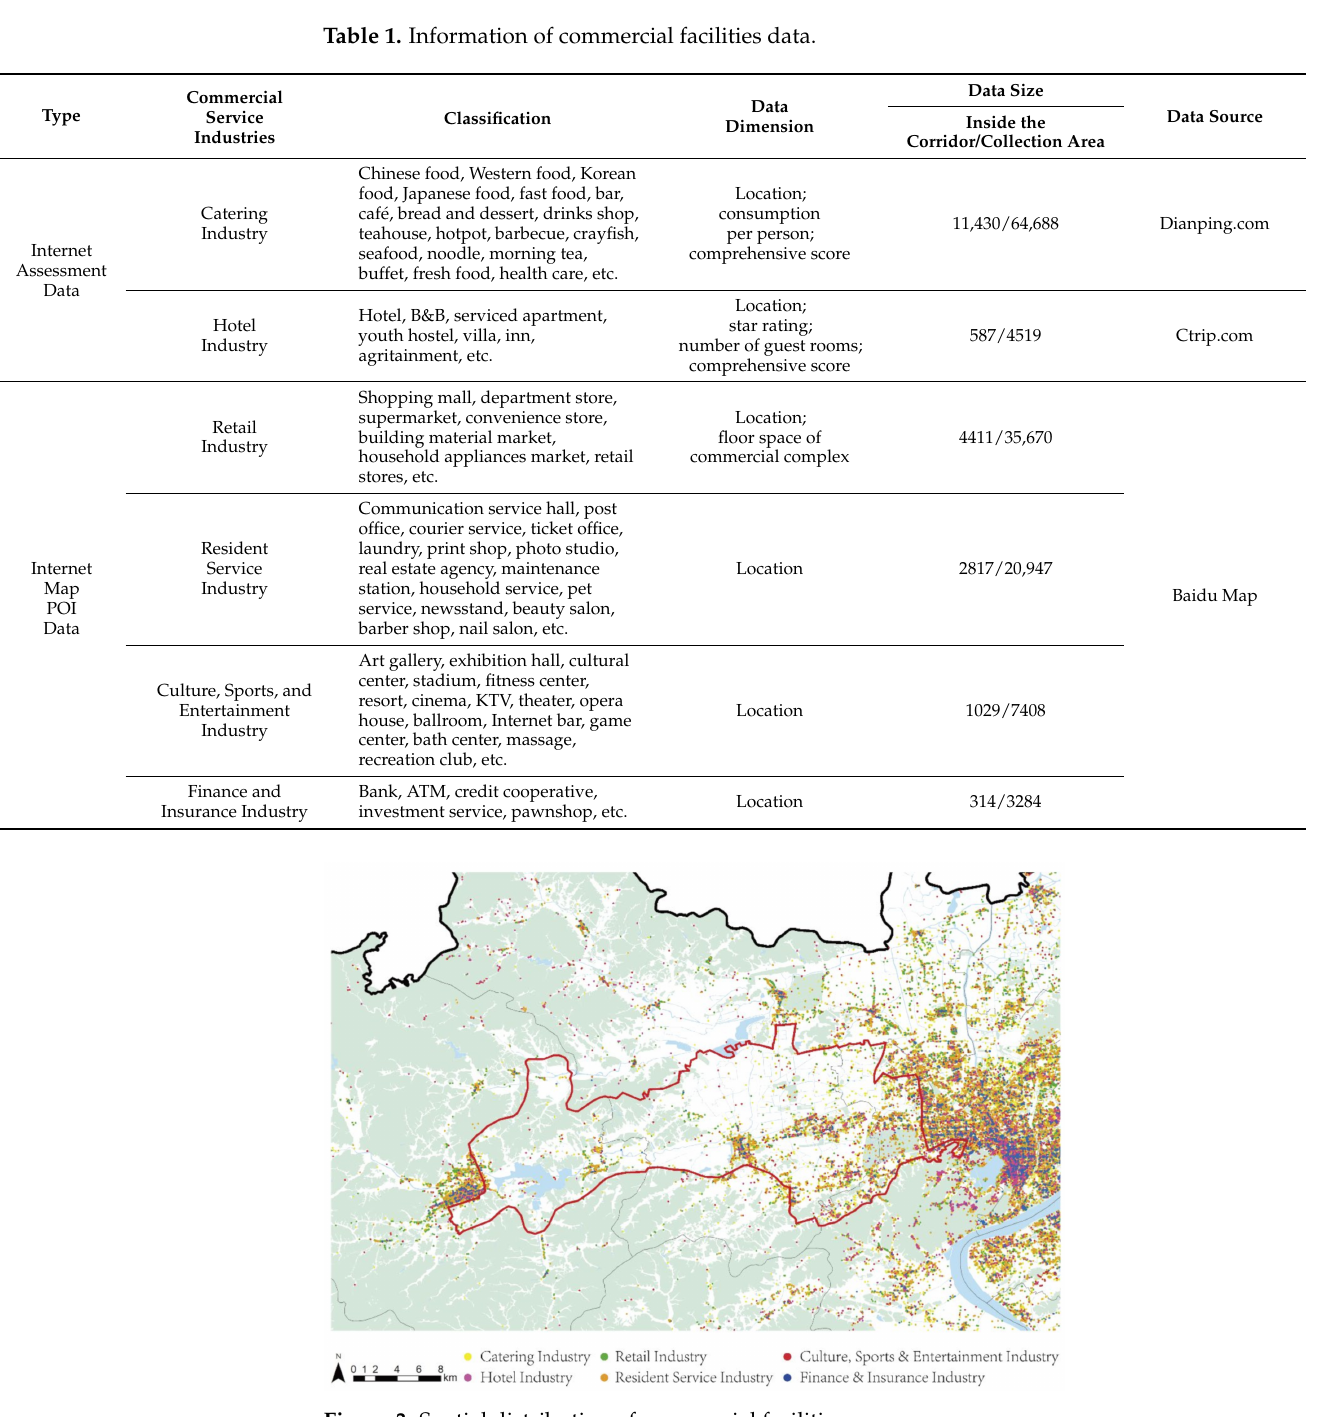
Figure 3. Spatial distribution of commercial